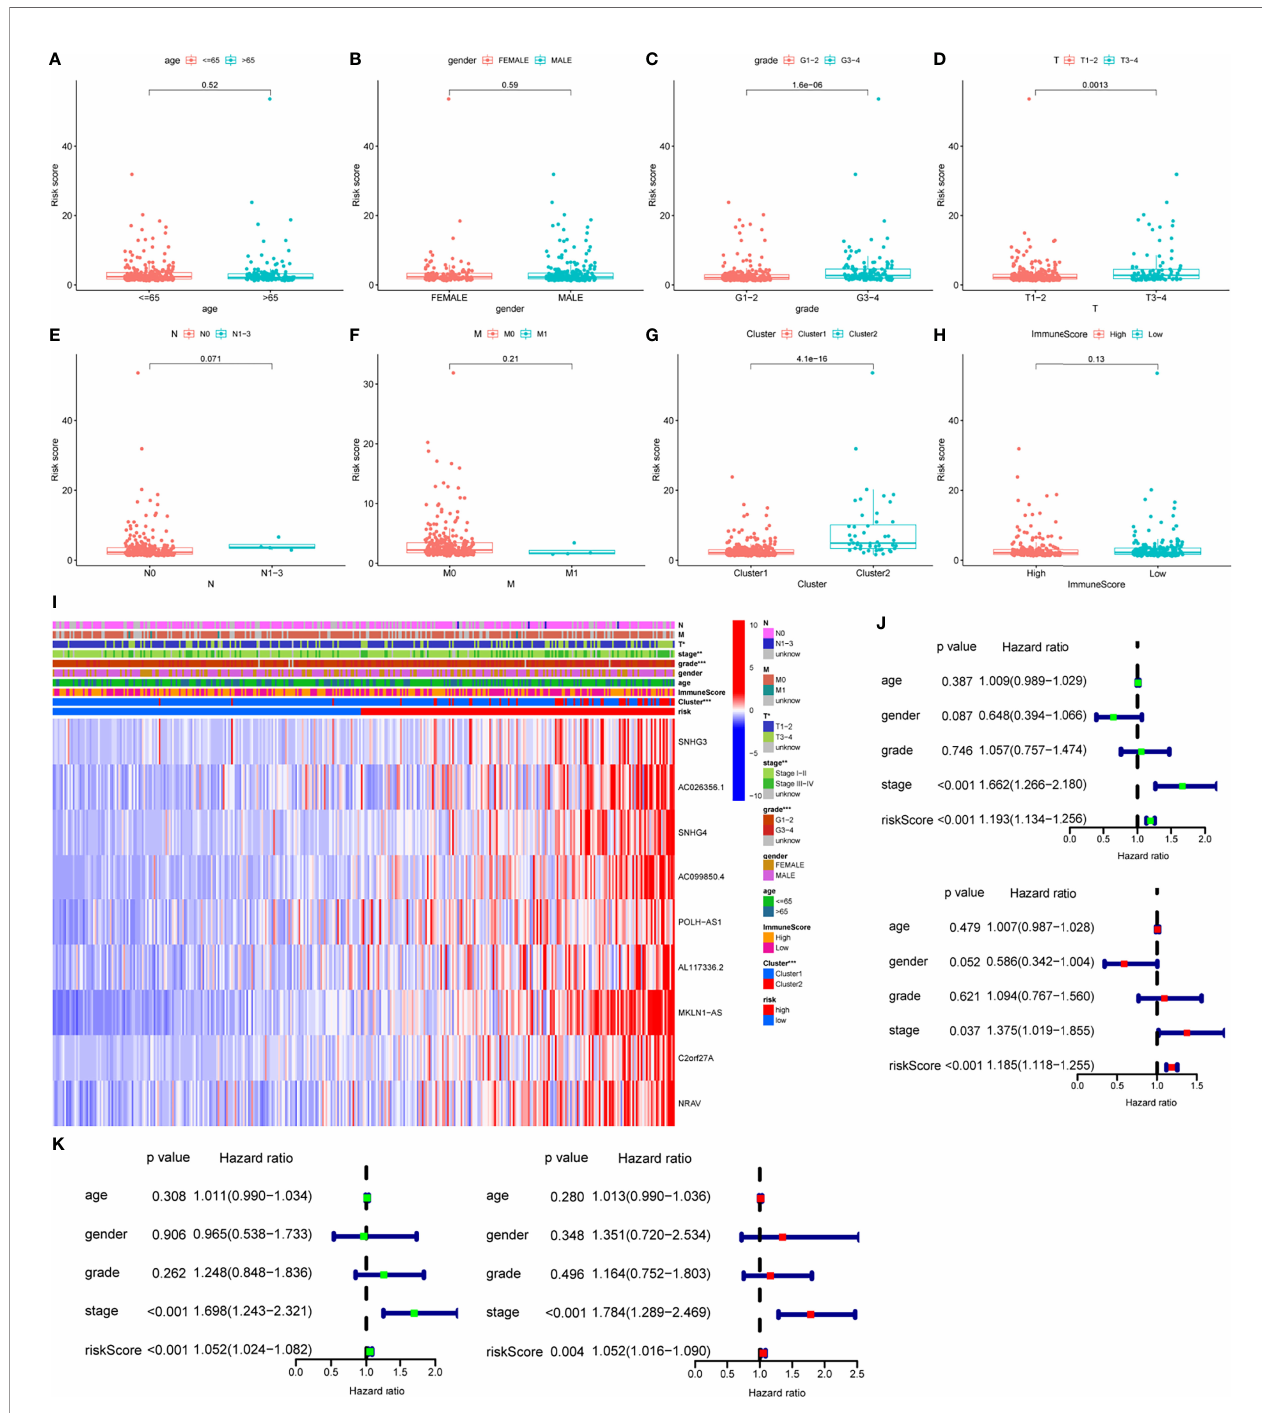
FIGURE 6 | Box plots, heatmap and forest plots of lncRNAs and clinical factors-related. (A – H) Box plots of risk score by age, gender, grade, tumor, node, metastasis, cluster, immunescore, respectively, (I) Heatmap of lncRNAs, clinical factors, immunescore and cluster-related, (J, K) Forest plots of univariate and multivariate analysis in training and testing sets, respectively. ** means P<0.01. *** means